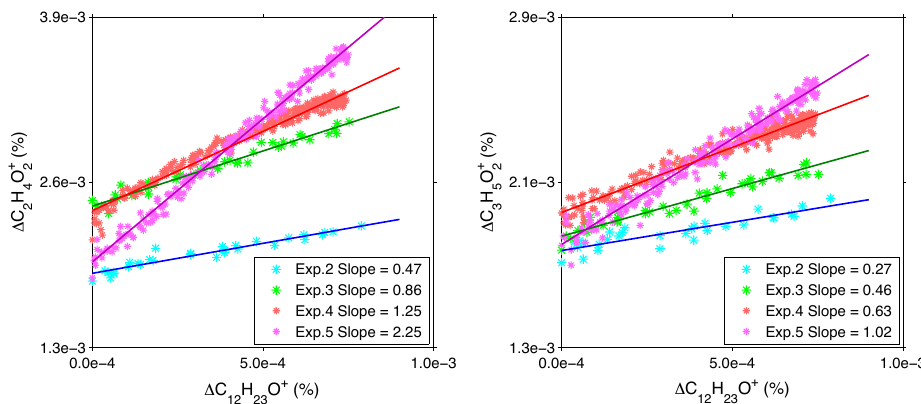
Fig. 7. Time-dependent evolution of AMS measured ion intensities of C 2 H 4 O +